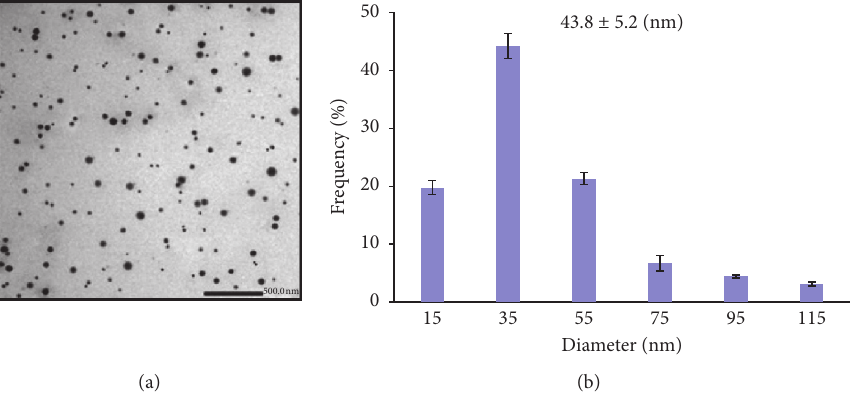
Figure 7: TEM image and size distribution of the SeNP/OCS